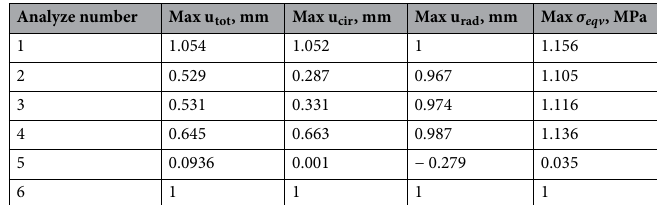
Table 5. Results in relative portion to analysis No. 6—FSI with rotation.